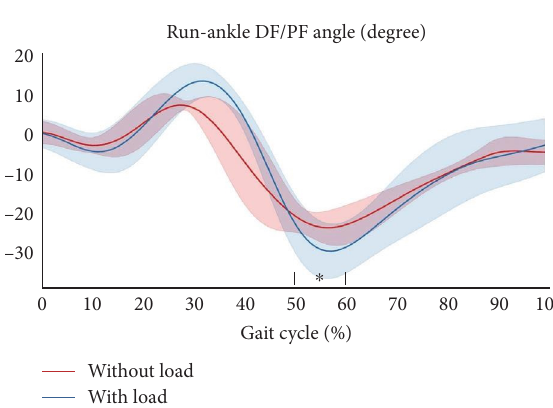
F IGURE 4: Raw data of the hip, knee, ankle joint angles during run- ning with and without load carriage. The x -axis shows the normal- ized gait cycle in percentage. ∗ Indicates signi fi cant difference between with and without load carriage ( p < :